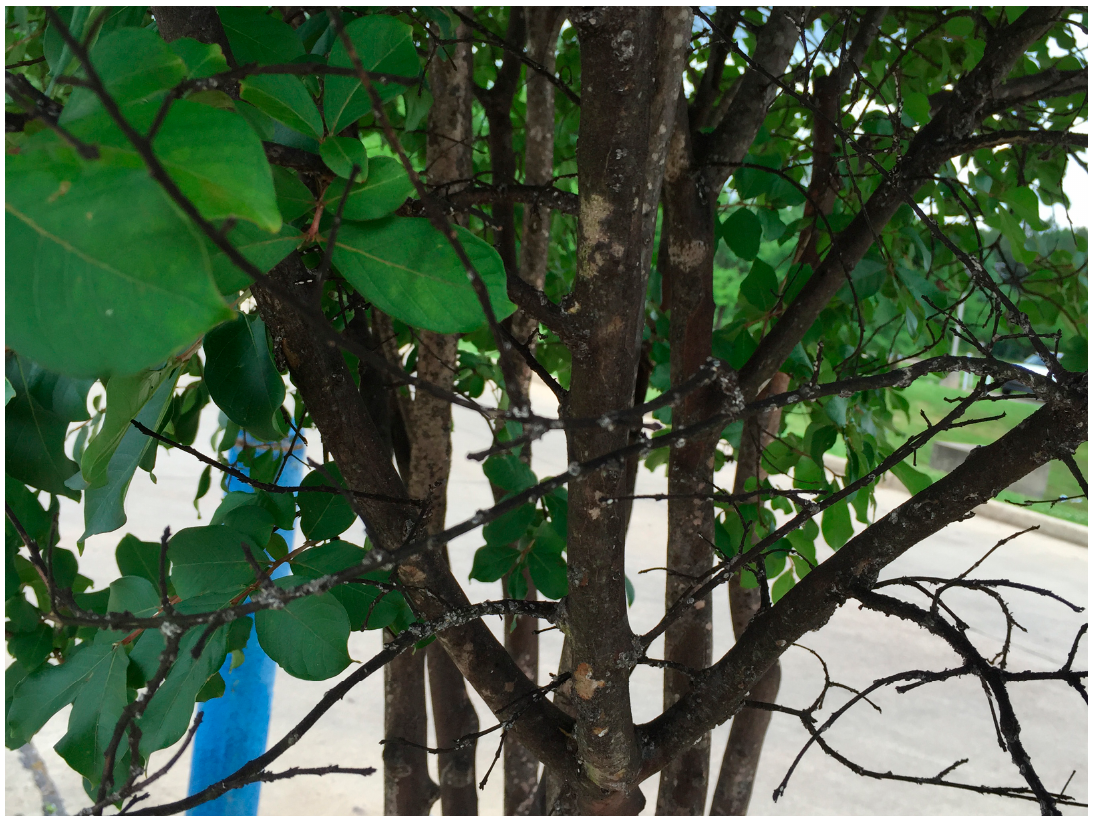
Figure 1. Branch dieback and accumulation of black sooty mold on the crapemyrtle tree infested with Acanthococcus lagerstroemiae .